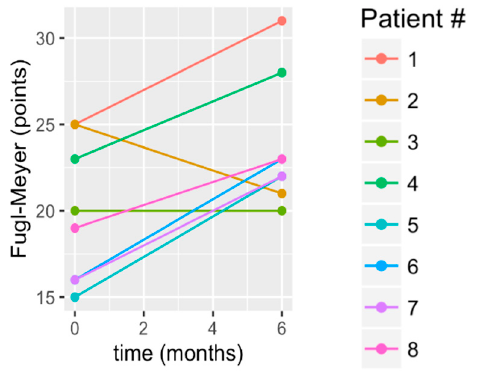
Figure 3. Change in lower extremity Fugl-Meyer score from baseline to 6 months. Key: Fugl-Meyer; (LE): Lower Extremity